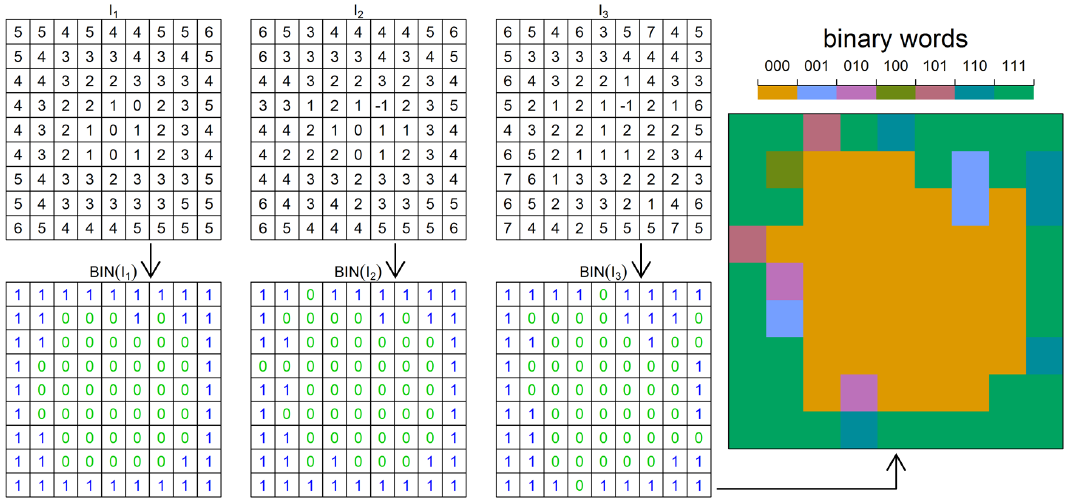
Figure 11. Construction of “binary word” classification for a designed data set. The data are the same as those for Fig. 5. On the left, the three images are binarized (BIN) from the upper to the lower panel. Values larger than the median are converted to 1 (blue), values lower are converted to 0 (green). The right panel shows the aggregated words for the three data sets. Not every possible occurrence of words is produced (maximum: 2 3